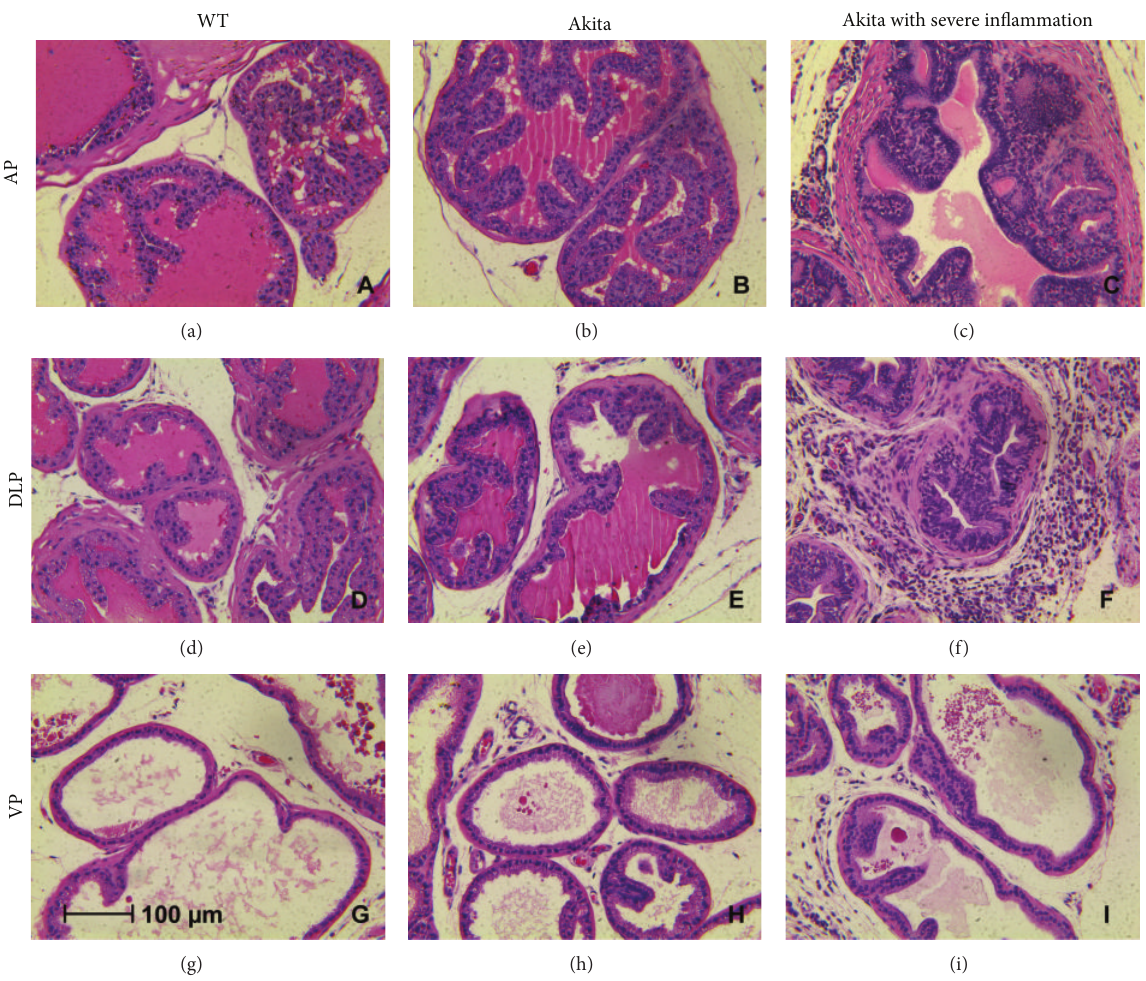
Figure 1: Representative H&E stained sections of the AP, DLP, and VP of 18-weeks-old DBA2J (WT: 𝑛 = 4 ), DBA2J.Ins2-Aktia (diabetic: 𝑛 = 3 ), or DBA2J.Ins2-Akita mice with severe inflammation (diabetic: 𝑛 = 1 ).